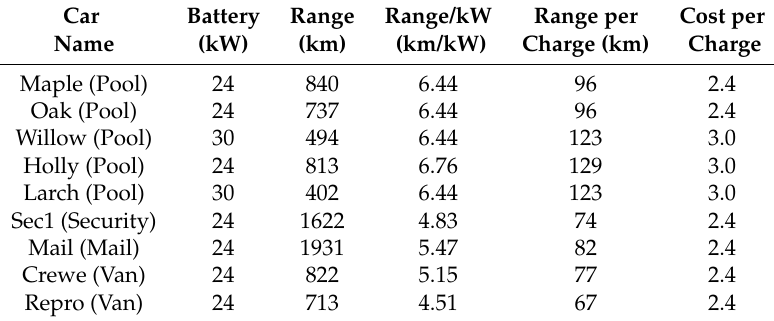
Table 1. PEV charge and mileage summary.